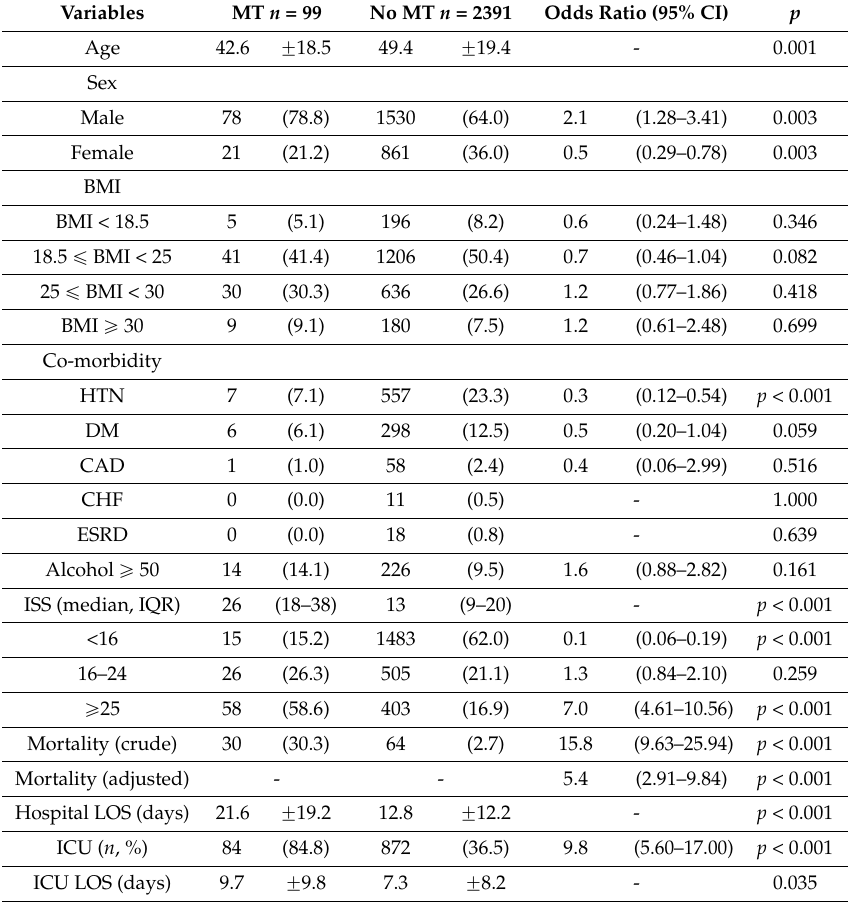
Table 1. Demographics and injury characteristics of patients with and without